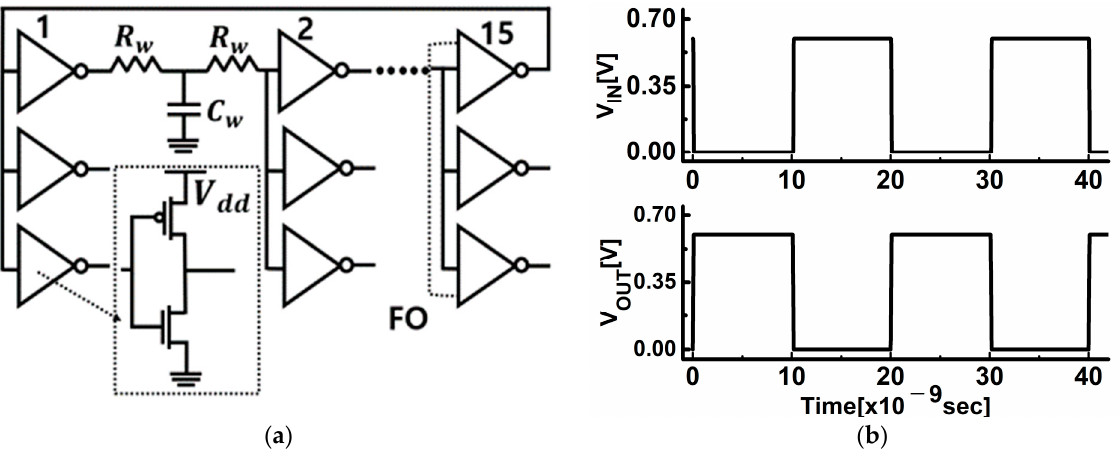
Figure 4. ( a ) Schematic of inverter ring oscillator with fan − out 3, which includes distributed inter- connect RC components; ( b ) the transient simulation results of designed inverter ring oscillator.